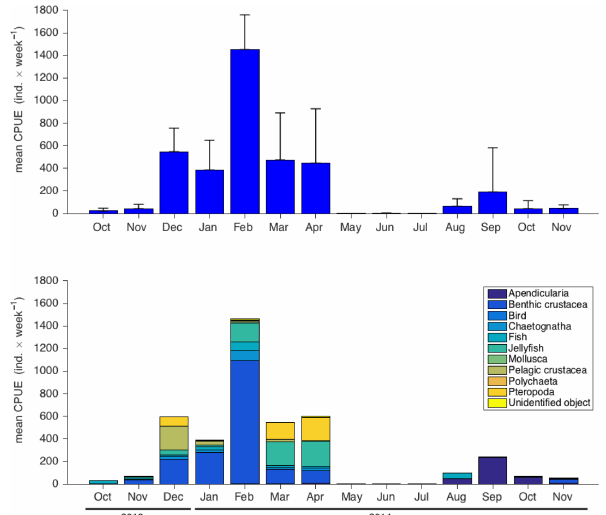
Figure 5. Seasonal cycle in total species abundance (upper panel) and species composition (lower panel) pooled per month of the year. For details with respect to “Catch per unit effort”, see the text.